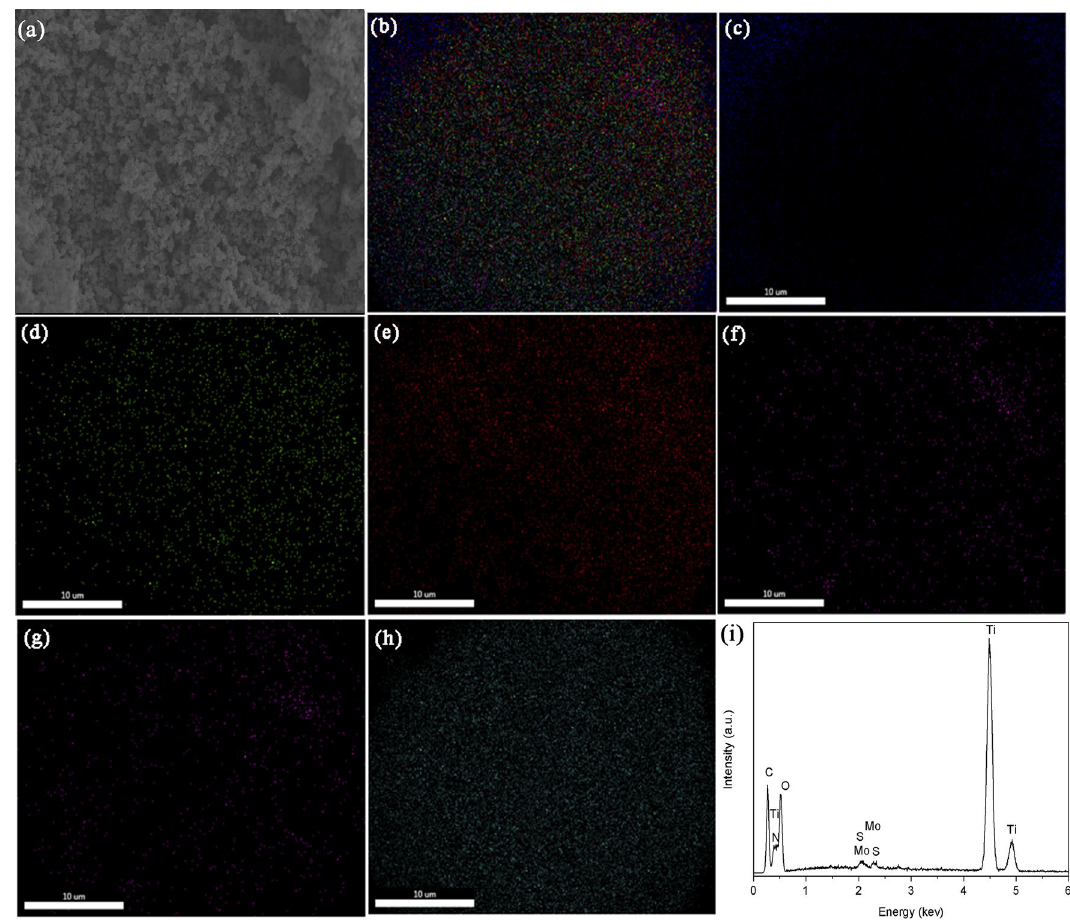
Figure 2. ( a ) SEM image of NH 2 -PDI/TiO 2 /MoS 2 photocatalyst; Element mappings of Mo, S, C, N, Ti, and O elements ( b ), C ( c ), N ( d ), O ( e ), Mo ( f ), S ( g ), and Ti ( h ) in the NH 2 -PDI/TiO 2 /MoS 2 photocatalyst; ( i ) EDX spectrum of NH 2 -PDI/TiO 2 /MoS 2